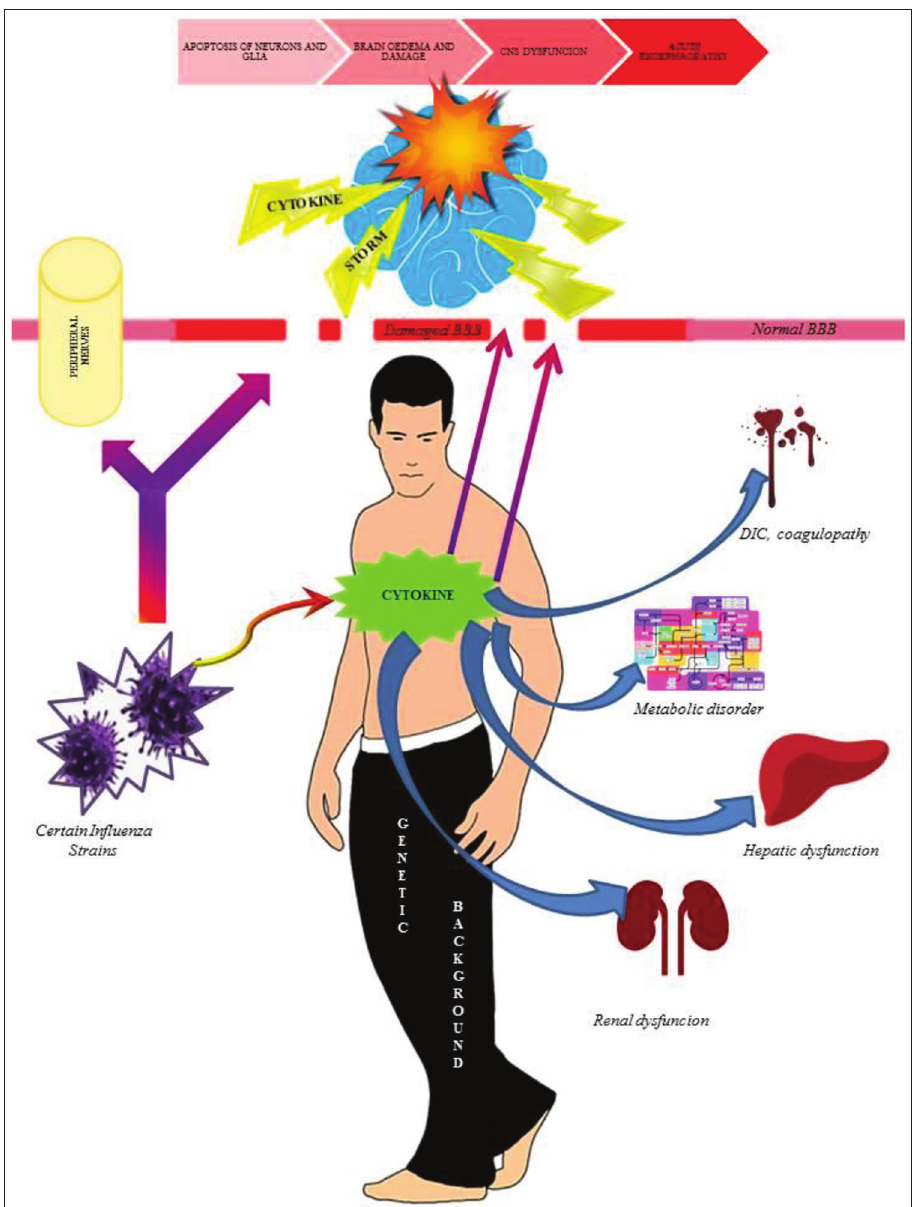
FIGURE 1. Etiopathogenesis of influenza-associated acute encephalopathy. In some patients with certain genetic background, abnormal hypercytokinemia in response to specific influenza viruses infection is observed. These cytokines penetrate BBB and damage the vas- cular endothelium, glia, and neurons causing edema and destruction of the brain tissue. Sometimes, viruses populate the CNS through peripheral nerves or damaged BBB inducing cytokine storm and, consequently, neuroinfection with encephalopathy. The above-men- tioned cytokine storm may contribute to hepatic or renal dysfunction, metabolic disorder, coagulopathy, and DIC. BBB: blood–brain barrier; DIC: Disseminated intravascular coagulation; CNS